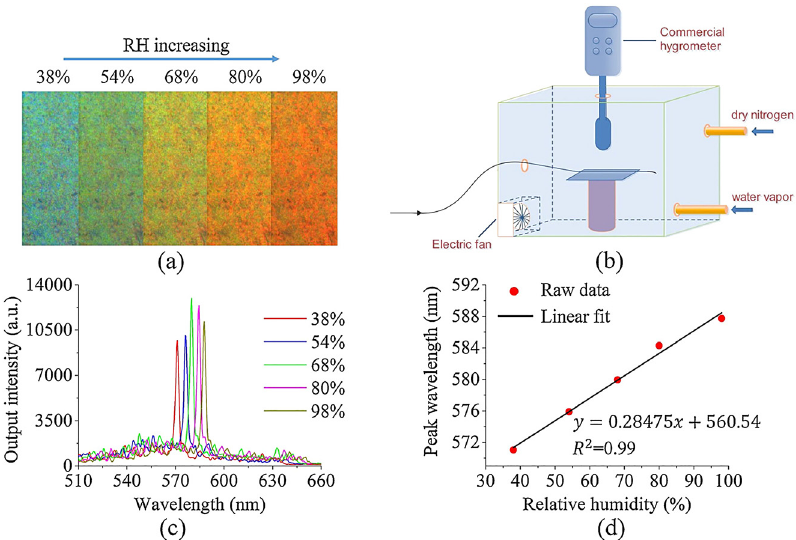
Figure 27: (a) × 20 micrographs of the planar CLC fi lmatdifferentRHlevels.(b)Schematic diagram of the experimental setup for RH testing. (c) and (d) show the output spectra and the laser emission wavelengths at RH levels of 38, 54, 68, 80, and 98% [181].